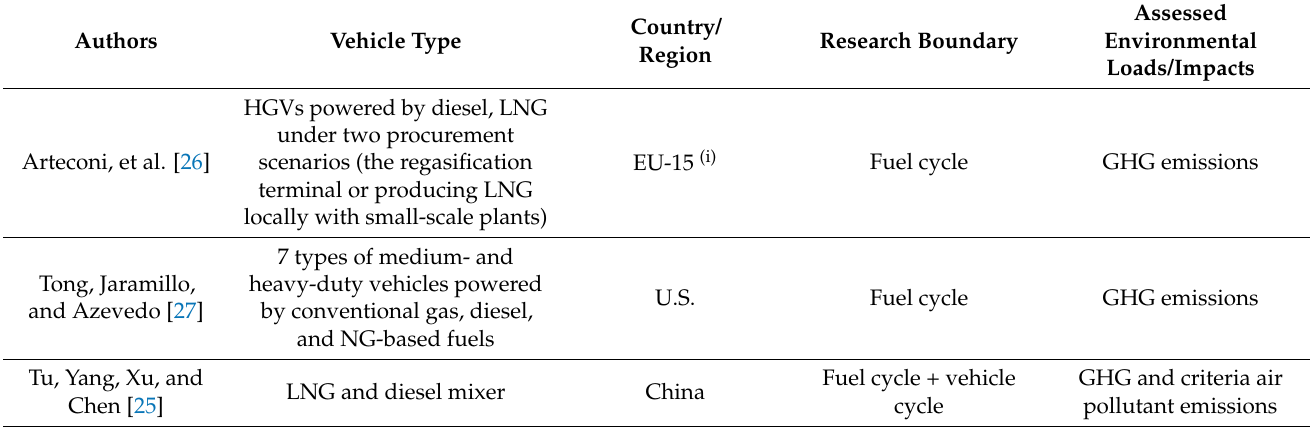
Table 1. Previous studies regarding the environmental performance of LNG